Question: Sum up the contents of this chart in one sentence.
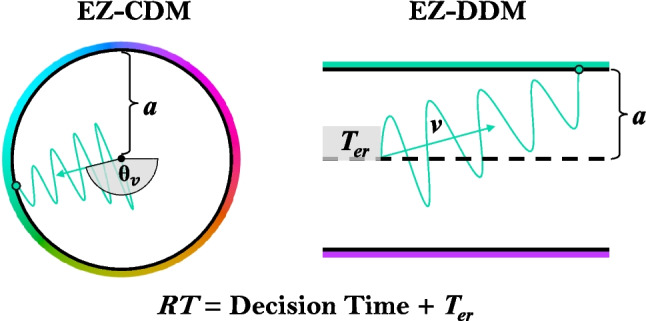
Answer: Left: EZ Circular Diffusion Model (EZ-CDM). The drift rate angle ( \documentclass[12pt]{minimal} \usepackage{amsmath} \usepackage{wasysym} \usepackage{amsfonts} \usepackage{amssymb} \usepackage{amsbsy} \usepackage{mathrsfs} \usepackage{upgreek} \setlength{\oddsidemargin}{-69pt} \begin{document}$$\theta _v$$\end{document} ) denotes the direction of evidence accumulation, and the radius indicates boundary separation ( a ). Right: EZ Diffusion Decision Model (EZ-DDM). The shaded area ( \documentclass[12pt]{minimal} \usepackage{amsmath} \usepackage{wasysym} \usepackage{amsfonts} \usepackage{amssymb} \usepackage{amsbsy} \usepackage{mathrsfs} \usepackage{upgreek} \setlength{\oddsidemargin}{-69pt} \begin{document}$$T_{er}$$\end{document} ) represents non-decision time, drift rate ( v ) captures the rate of evidence accumulation, and a denotes the boundary separation between an unbiased start point and decision boundary. Response time is the sum of the decision time (the time it takes to hit the boundary) and the non-decision time. Precision in the CDM reflects where the accumulating evidence crosses the circular boundary, whereas accuracy in the DDM reflects whether evidence terminated at the correct vs. error boundary